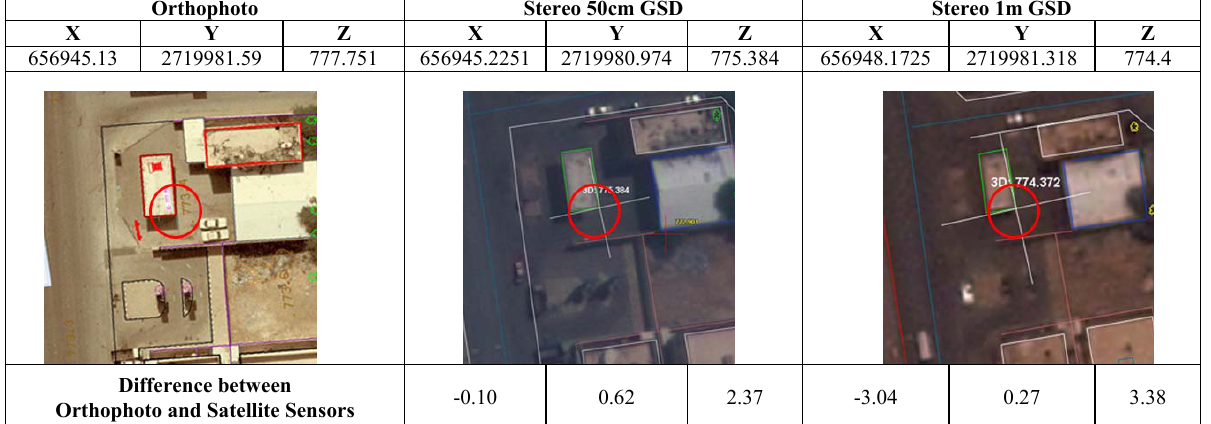
Table 1h. Showing capturing of building corner based on different resolutions of Stereopairs.